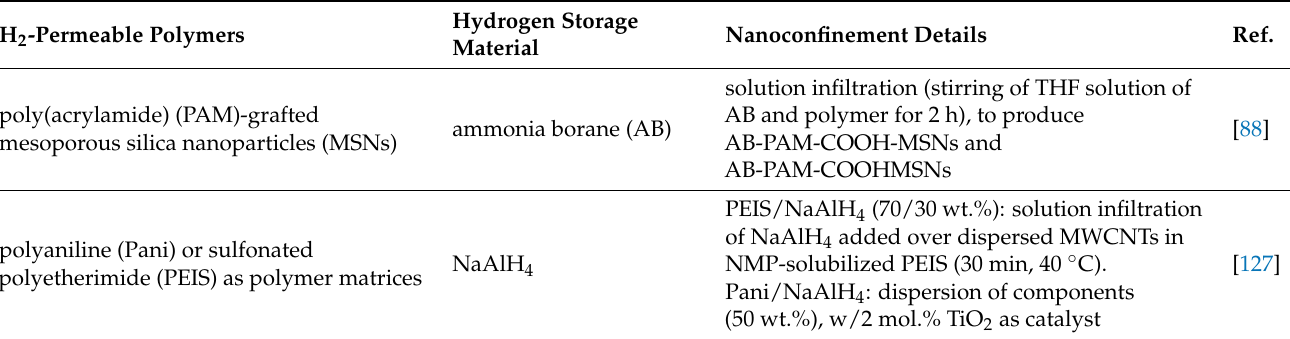
Table 6. Examples of gas-selective H 2 -permeable polymers used as covering shells for hydrogen storage